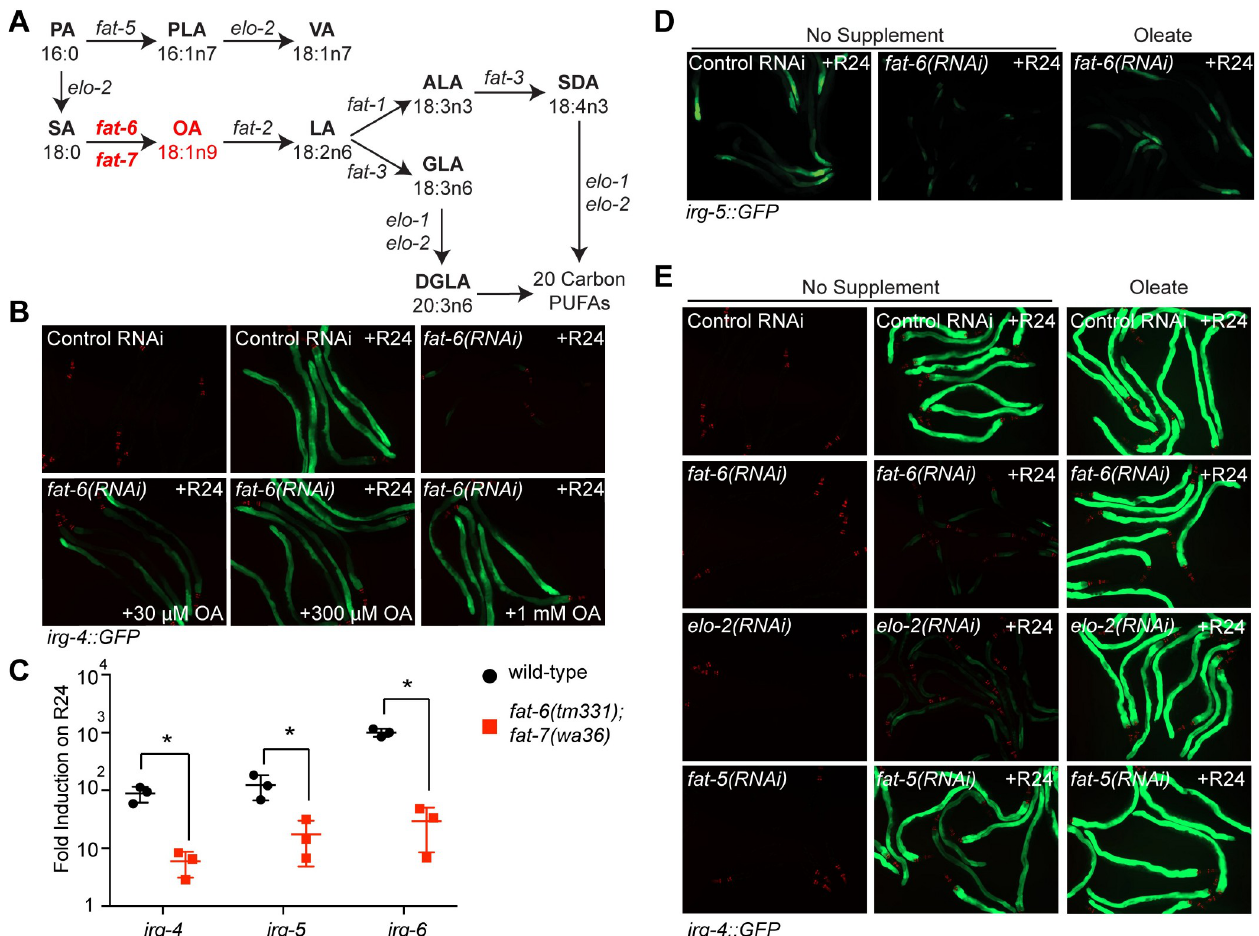
Fig 1. An RNAi screen identifies a role for MUFAs in the activation of C . elegans innate immune effectors. A. A schematic of the long-chain fatty acid synthesis pathway in C . elegans adapted from [6,17].Fatty acid nomenclature: X:YnZ, X indicates the number of carbon atoms, Y denotes the number of double bonds, and Z designates the position of the terminal double bond relative to the methyl end of the molecule. Abbreviations: ALA, α -linoleic acid; DGLA, di-homo- γ -linoleic acid; GLA, γ -linoleic acid; LA, linoleic acid; OA, oleate; PA, palmitic acid; PLA, palmitoleic acid; SA, stearic acid; SDA, stearidonic acid; VA, vaccenic acid. B. The C . elegans irg-4 :: GFP immune reporter was exposed to control or fat-6(RNAi) bacteria seeded on plates containing control or the indicated levels of oleate. The animals were then transferred at the L4 stage to plates containing R24 for approximately 18 hours. Red pharyngeal expression is the myo-2 :: mCherry co-injection marker, which confirms the presence of the transgene. C. Expression of the immune effectors irg-4 , irg-5 , and irg-6 were determined using qRT-PCR in wild-type or fat-6(tm331);fat-7(wa36) mutant animals exposed to R24 or solvent control (1% DMSO) for six hours. Data are the average of three independent replicates, each normalized to a control gene and presented as fold induction in R24-exposed vs. solvent control- exposed animals in the indicated genetic background. Error bars show standard deviation. Significance was determined by t -tests, � p < 0.05. D. Animals containing the irg-5 :: GFP immune reporter were grown as described above and exposed to R24. All animals had a Rol phenotype, which confirms the presence of the transgene. E. C . elegans containing the irg-4 :: GFP immune reporter were fed RNAi bacteria targeting the indicated genes on plates containing control or oleate and exposed to R24, as described above.